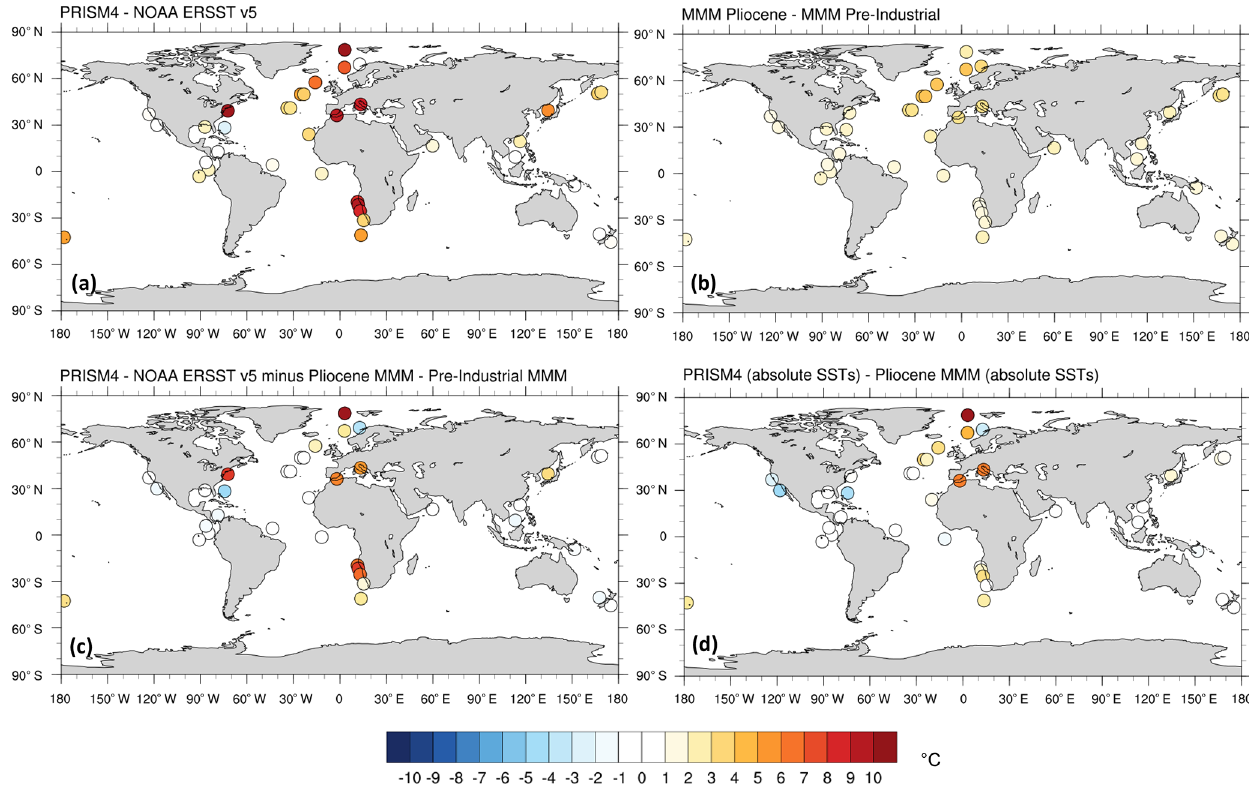
Figure 8. (a) PRISM4–NOAA ERSSTv5 SST anomaly for the data points described in Sect. 4. (b) Multi-model mean Plio Core –PI Ctrl SST anomaly at the points where data are available. (c) The difference between the SST anomaly derived from the data (a) and that of the multi-model mean (b) . (d) The PRISM4 SST data minus the Plio Core multi-model